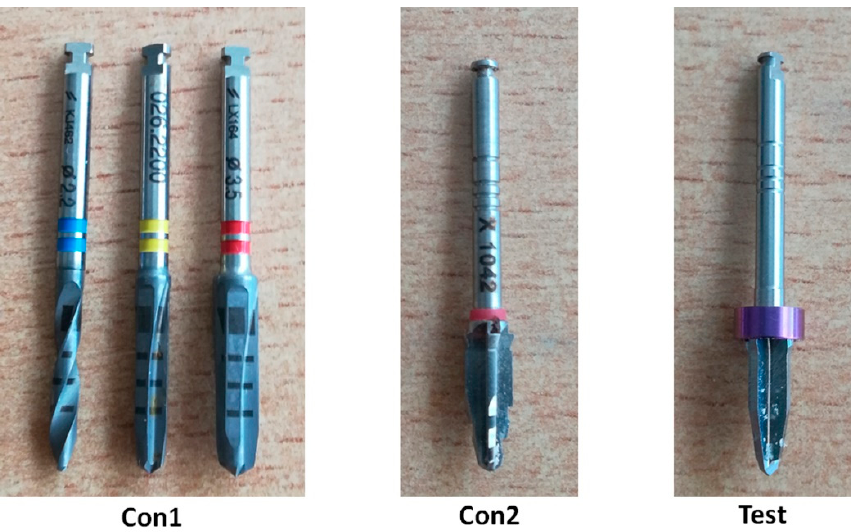
Figure 2. Image of the drill systems used for the osteotomies in the 3 groups.